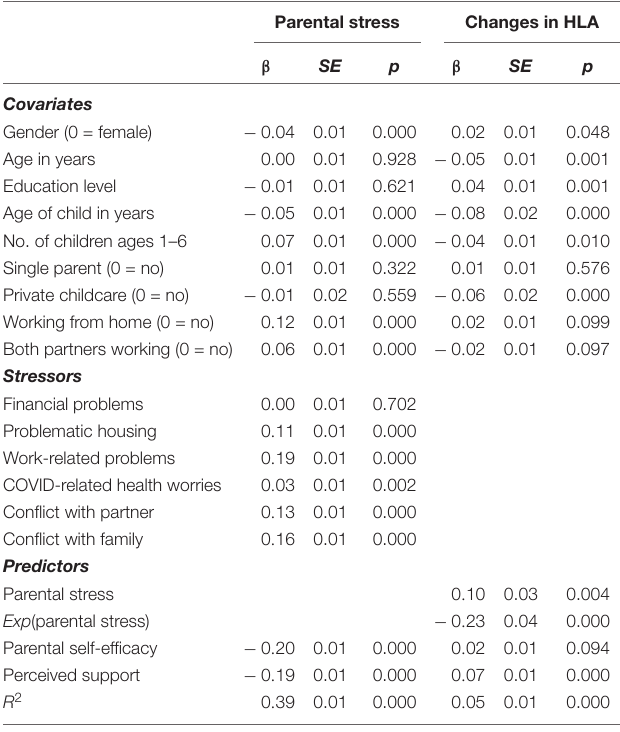
TABLE 4 | Relation between parental self-efficacy, perceived support, perceived stress, and changes in